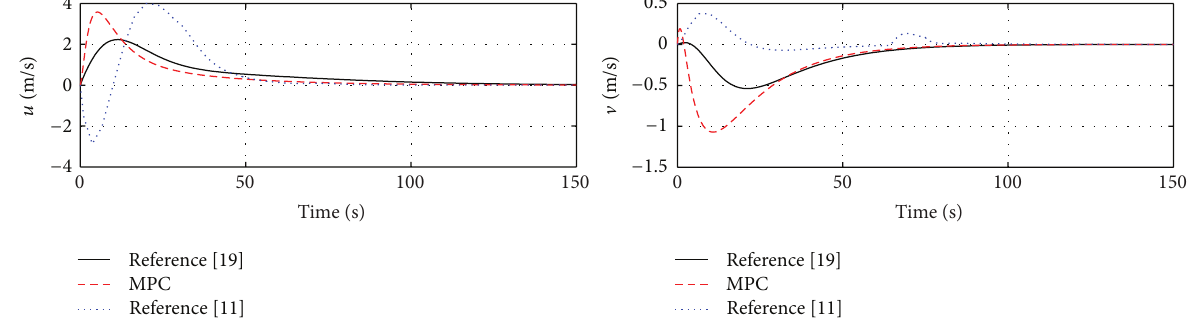
Figure 4: Trajectory of 𝑢 and V .